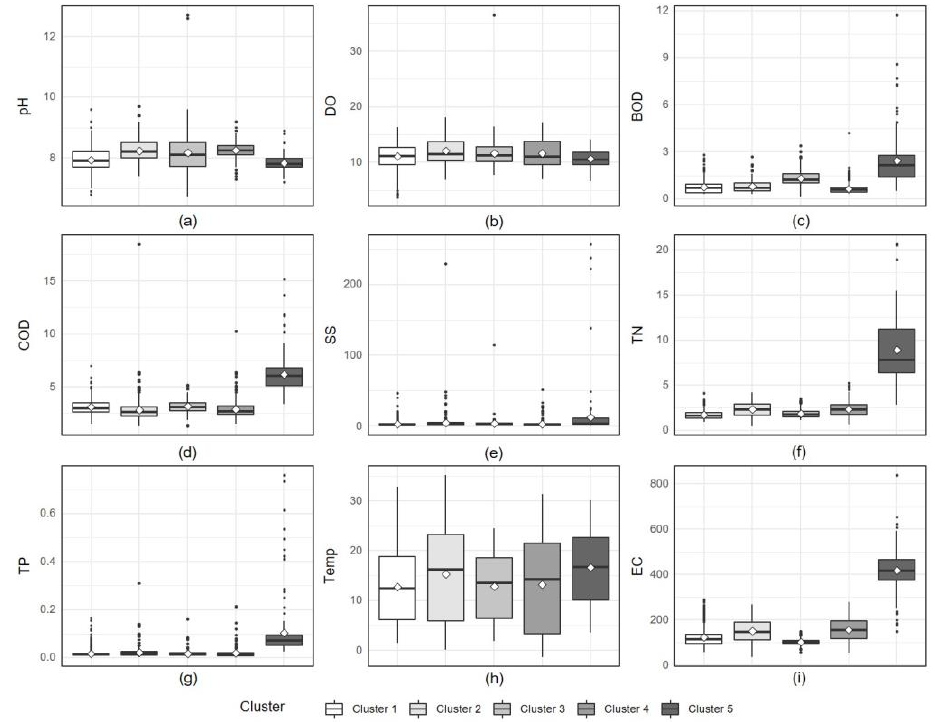
Figure 7. Cluster-specific boxplots for each variable when using the Dynamic Time Warping (DTW) algorithm about ( a ) pH, ( b ) DO, ( c ) BOD, ( d ) COD, ( e ) SS, ( f ) TN, ( g ) TP, ( h ) Temp, and ( i ) EC.